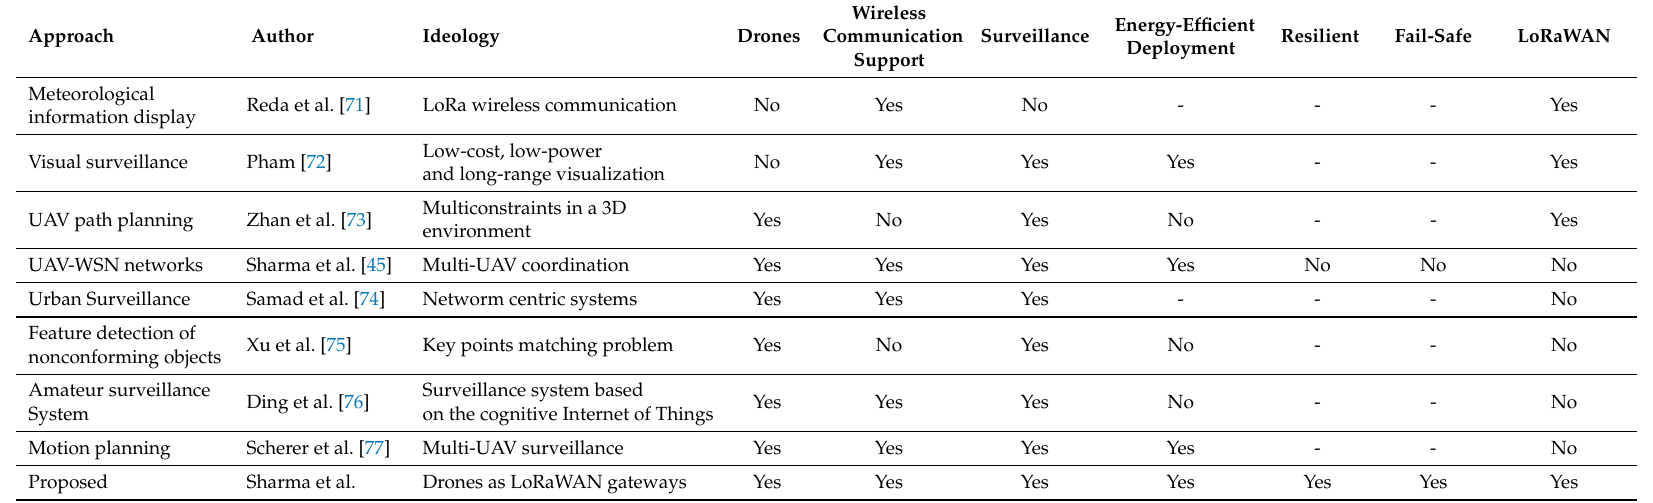
Table 3. Comparison of the proposed approach with the state-of-the-art solutions for